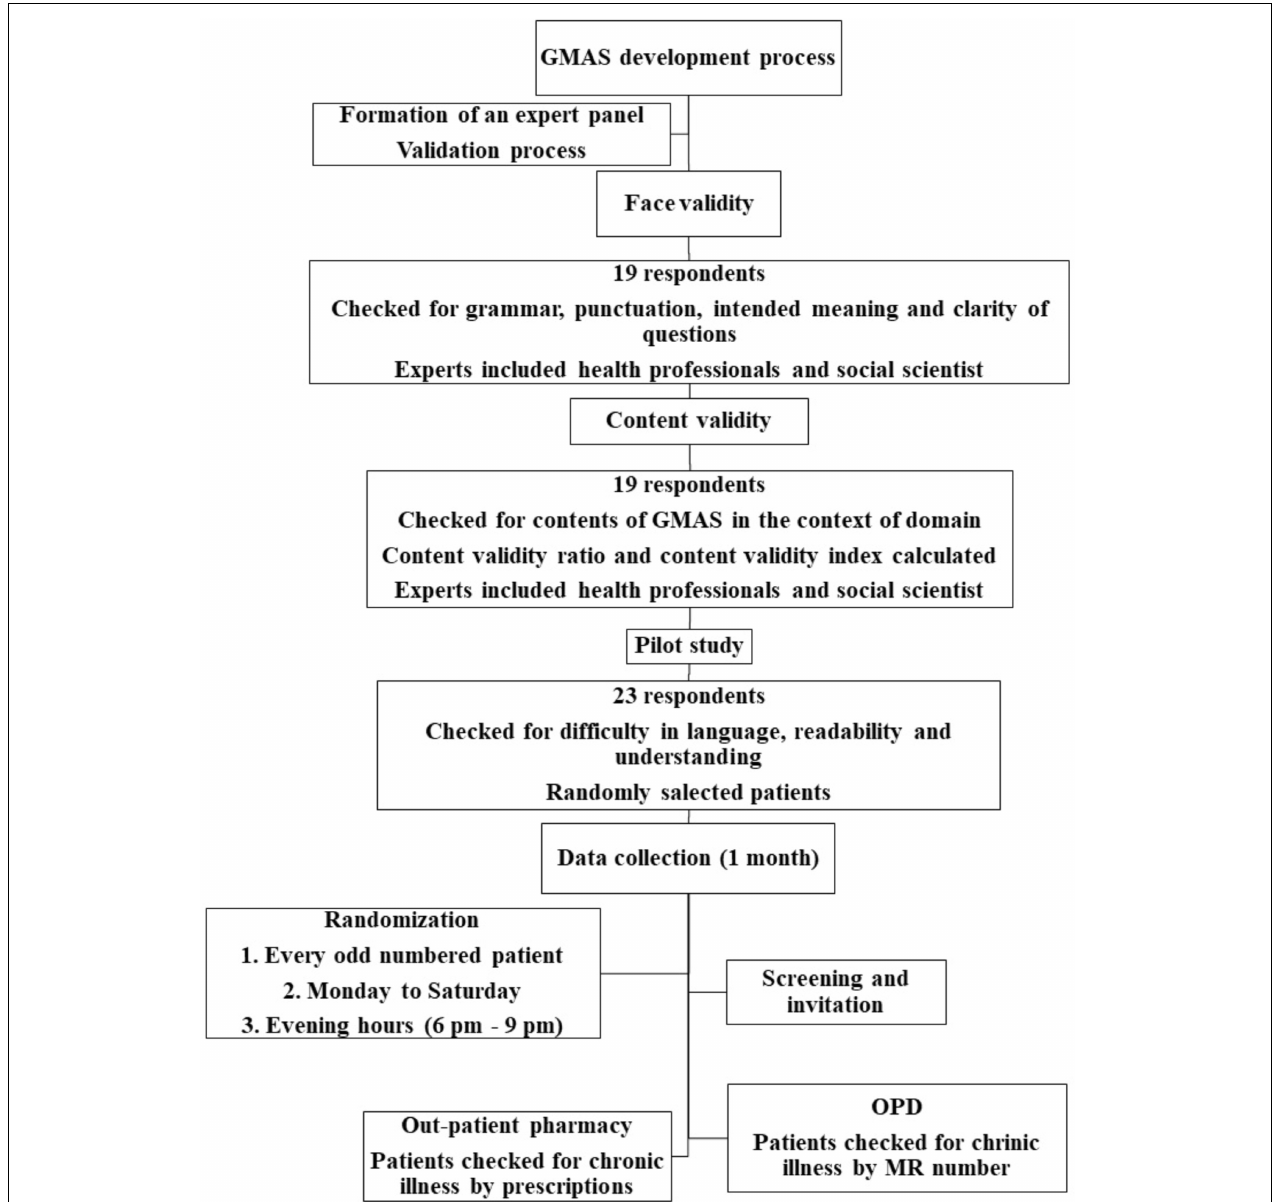
FIGURE 1 | GMAS concept, design and